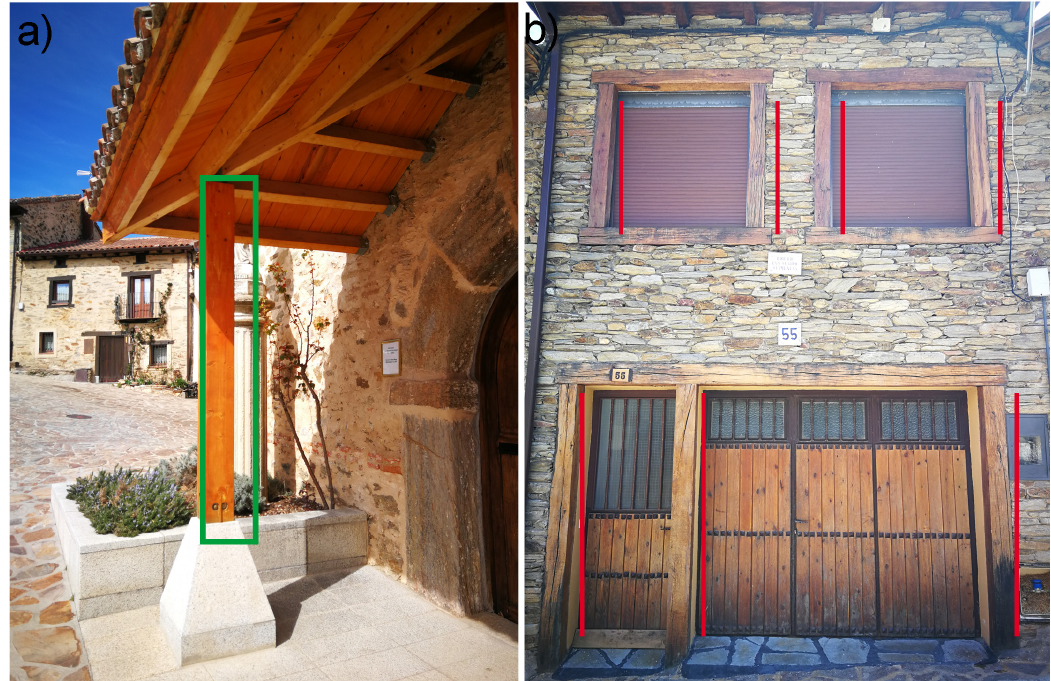
Figure 1. ( a ) Porch column of a church (Madrid) (green rectangle) and ( b ) pillar supports of a façade of a rural house (Madrid) (red